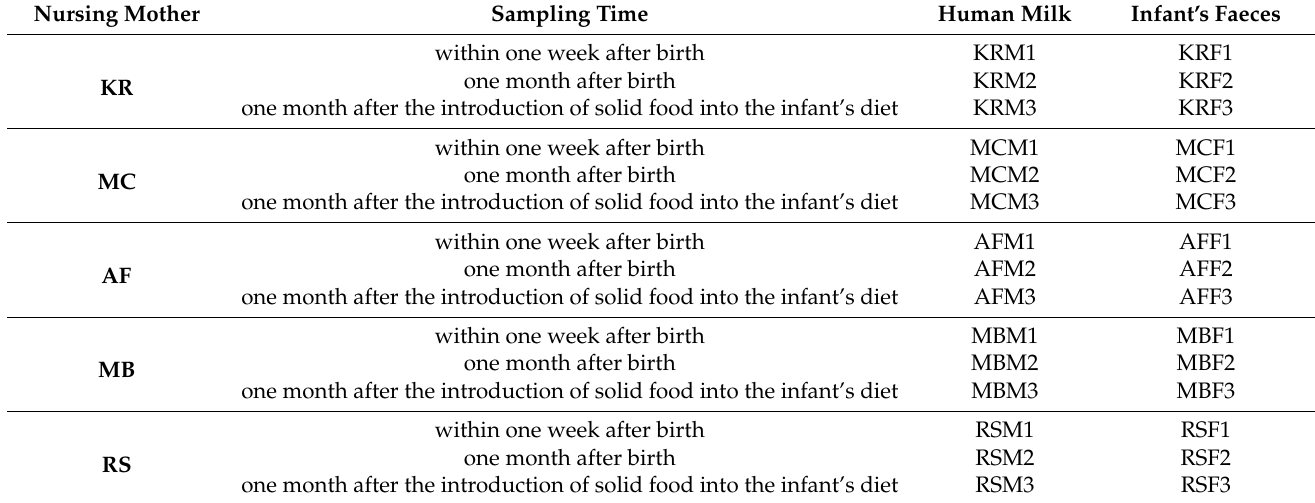
Table 3. Labels of human milk and infant faecal samples used in this